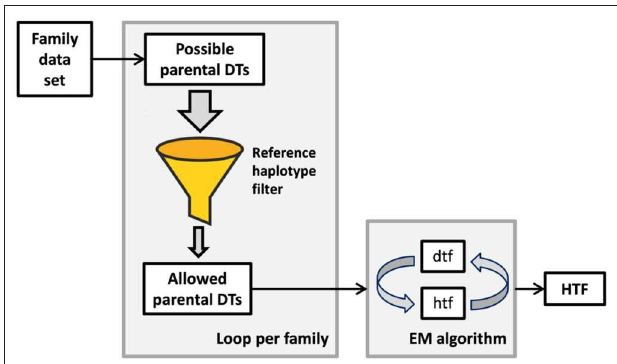
FIGURE 1 | Simplified workflow of our haplotype frequency estimation approach. The number of 16-locus KIR diplotypes per individual is reduced by inference from a family context and subsequent filtering via a set of reference copy number haplotypes. Only diplotypes that can be explained by a pair of reference haplotypes are allowed. Remaining ambiguities are resolved in a conventional expectation-maximization (EM) algorithm. DT, diplotype; dtf, preliminary diplotype frequencies; htf, preliminary haplotype frequencies; HTF, final haplotype